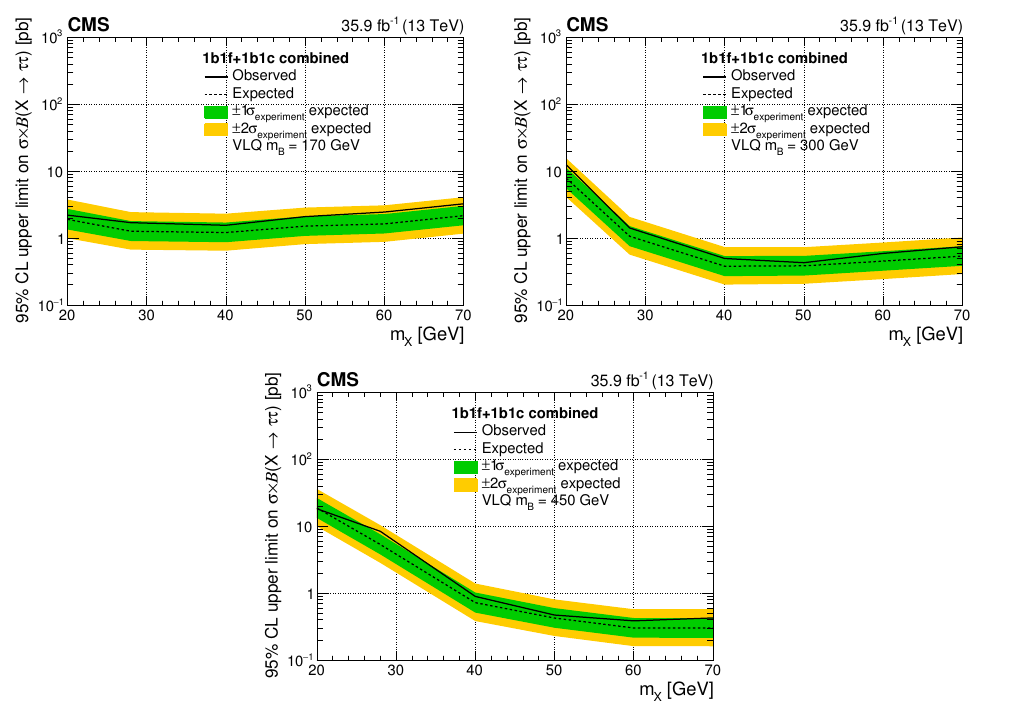
Figure 5 . Observed (solid) and expected (dotted) limits at 95% con(cid:12)dence level on the product of cross section for the production of the qbX signal and branching fraction X ! tt , obtained from the combination of the e t and mt channels. The m values of 170 (upper left), 300 (upper right), and h h B 450 GeV are considered. The green and yellow bands represent the one and two standard deviation uncertainties in the expected